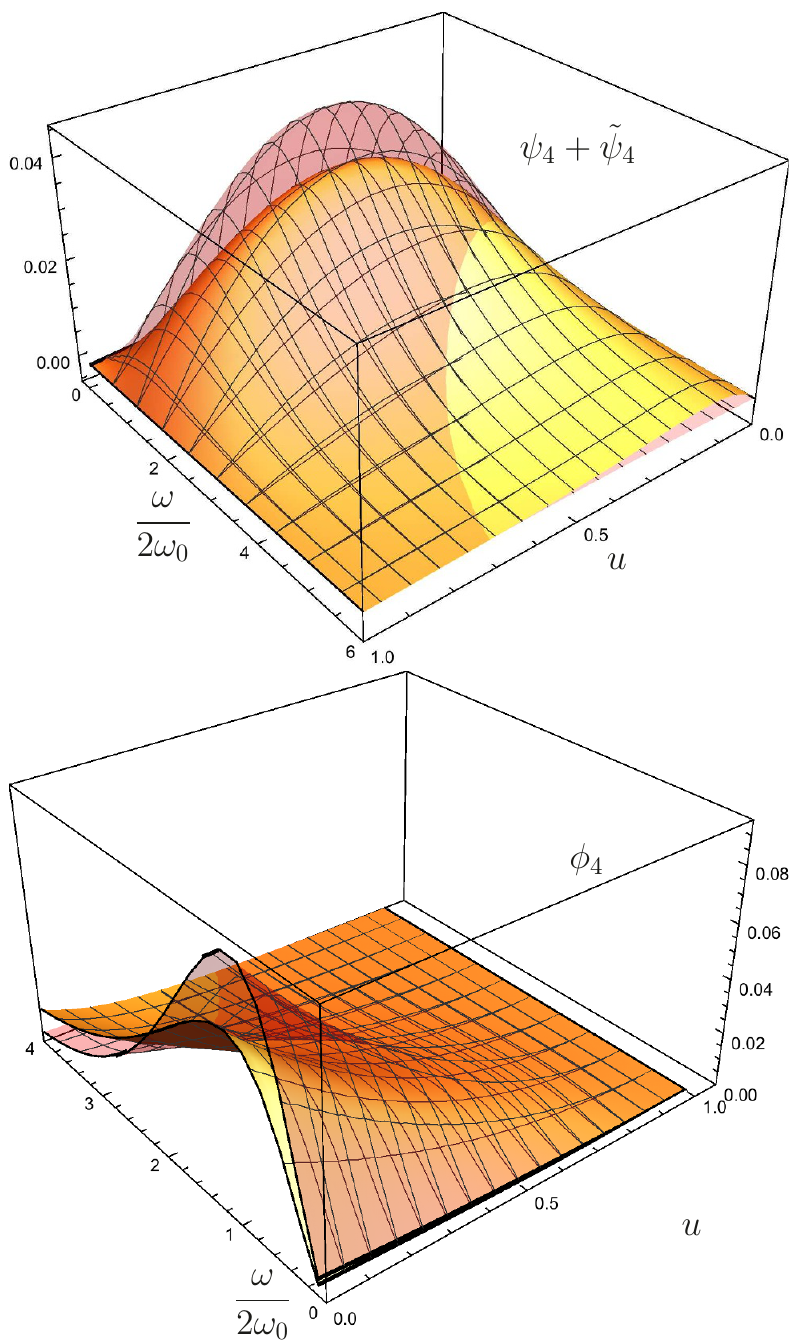
Figure 3 . Scale dependence of the DA ψ 4 + ˜ ψ 4 (upper figure) and φ 4 (lower figure) omitting the overall prefactor ( λ 2 + λ 2 ) /ω 2 . The DAs at the scale µ = 2 . 5 GeV (yellow) are overlaid with the E E 0 input ones (rose) in (5.8) assuming µ 0 = 1